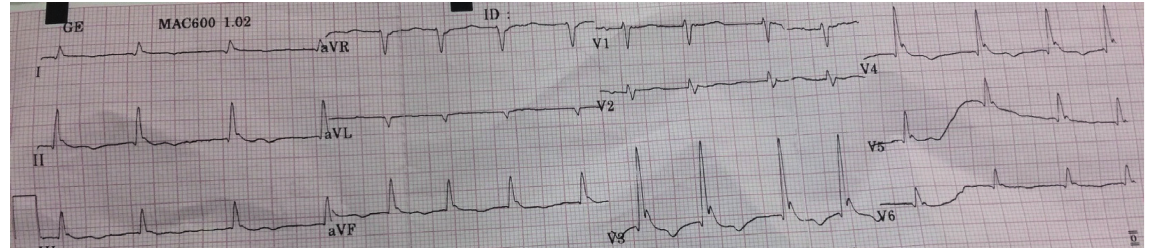
Figure 2: Admission EKG. Table 1: ABG and biological values evolution throughout the